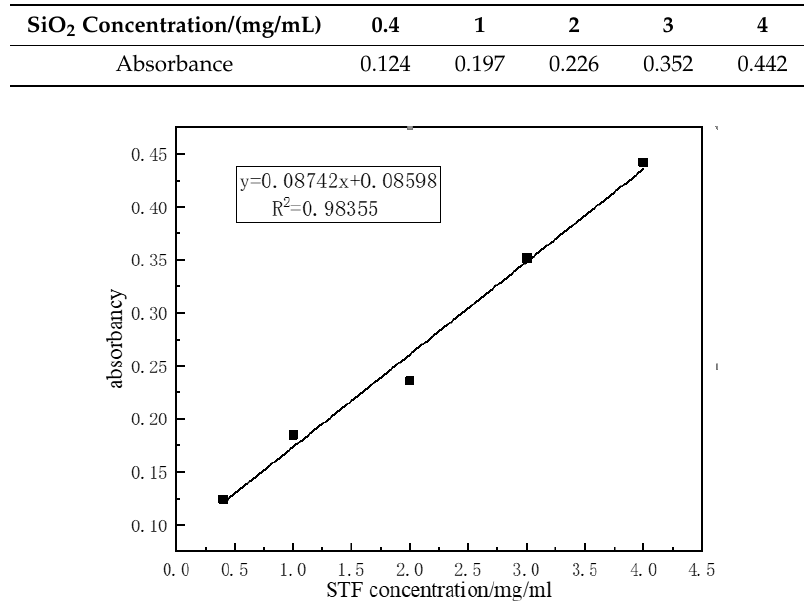
Figure 3. Standard curve of STF.